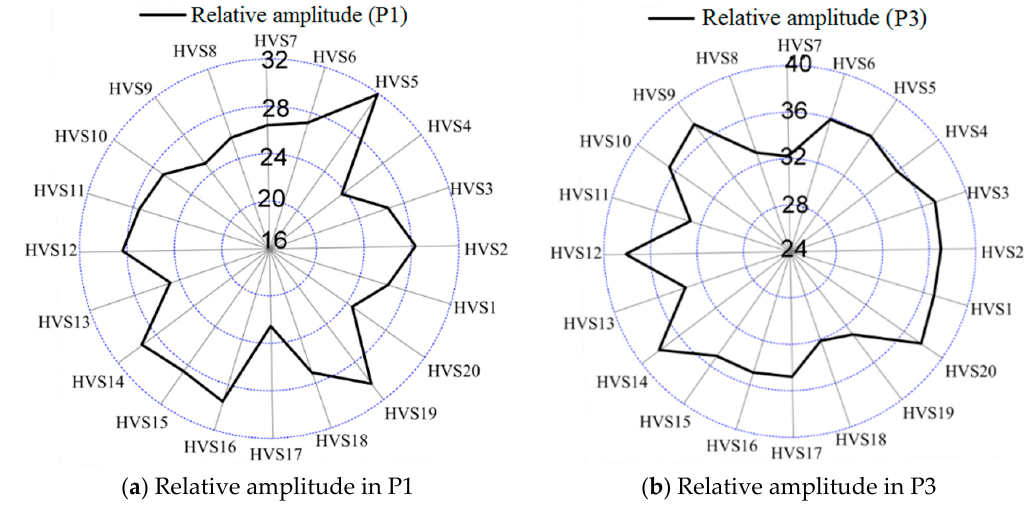
Figure 13. Distribution of relative amplitude in the vaneless space at operating points P1 and P3.